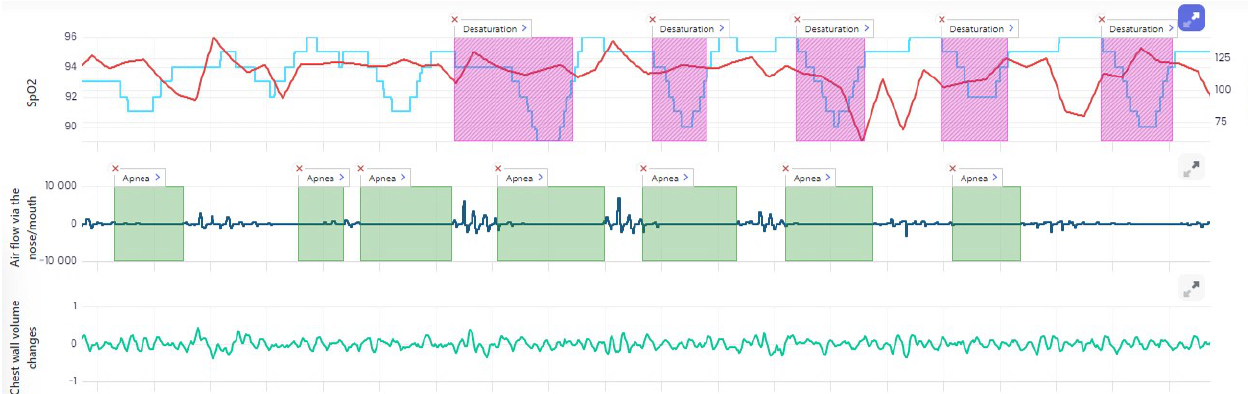
Figure 4. Sleep apnea reading, confirmed by polysomnography. 4. Discussion No guidelines for the treatment of patients with the post COVID syndrome have been issued so far. Patients who have recovered from SARS-CoV-2 infection can present vari- ous symptoms, such as fatigue, muscular pain, problems sleeping, cough, breathlessness,